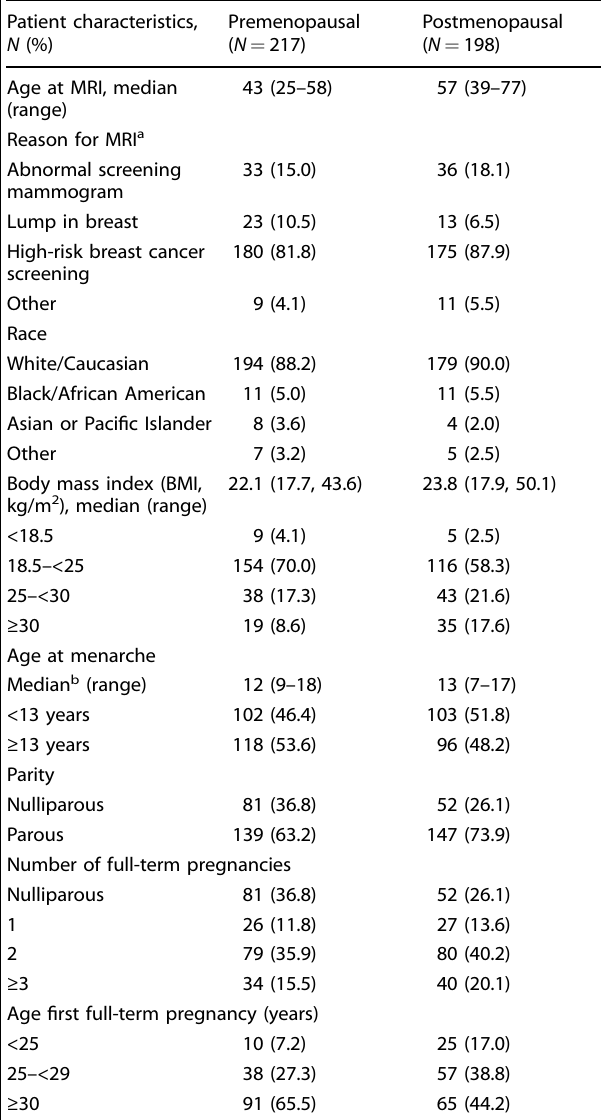
Table 1. Characteristics of the study population by menopausal status at the time of MRI.